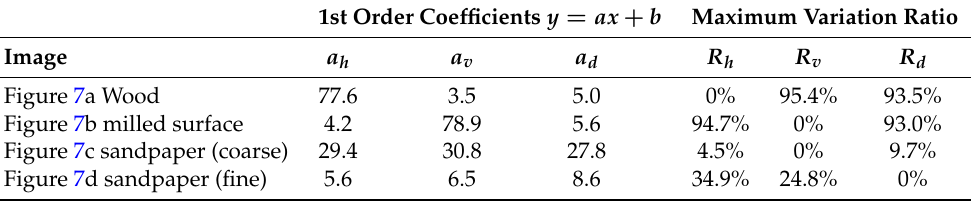
Figure 7b milled surface Figure 7c sandpaper (coarse) Figure 7d sandpaper